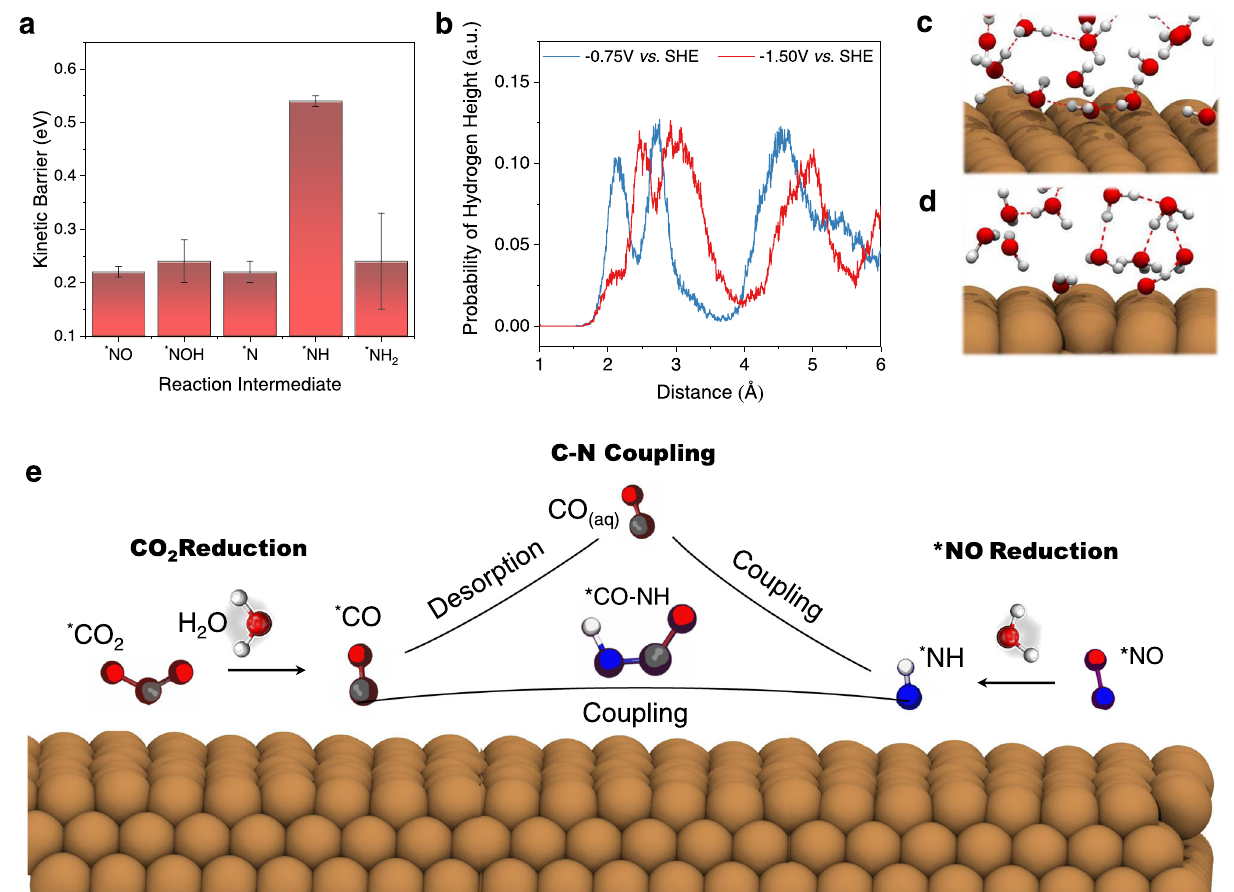
Fig. 5 | Reaction mechanisms at about -1.5V vs SHE. a Kinetic barriers of * NO reduction toward ammonia (NH 3 ) formation at ~ -1.5V vs SHE on the Cu(100) sur- face. b Probabilityofdistributionofhydrogenheightalongdirectionnormaltothe Cu(100) surface. Snapshots of the interface at about c − 0.75V and d − 1.5V vs SHE